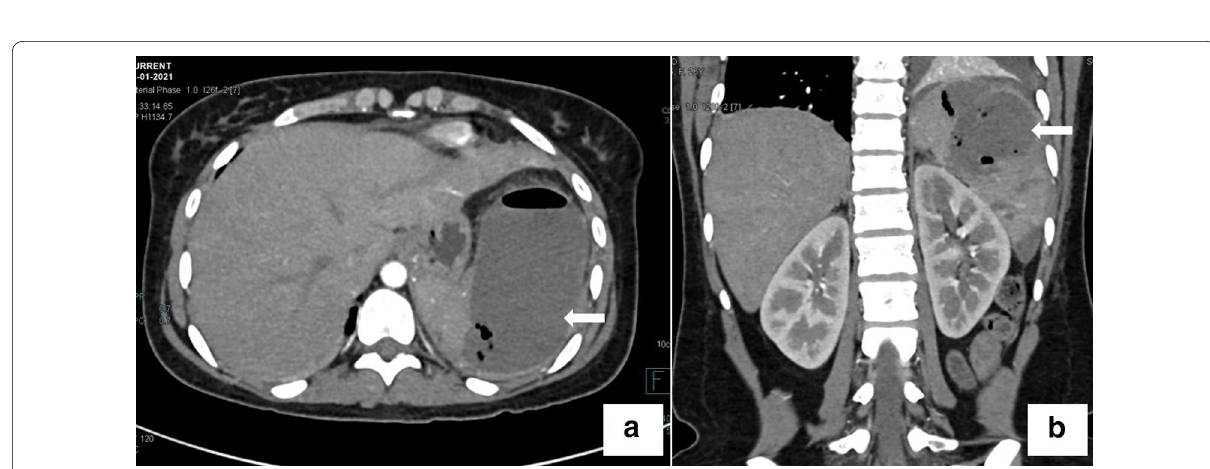
Fig. 4 CECT abdomen axial ( a ) and coronal ( b ) images showing splenic infarcts with abscess (white